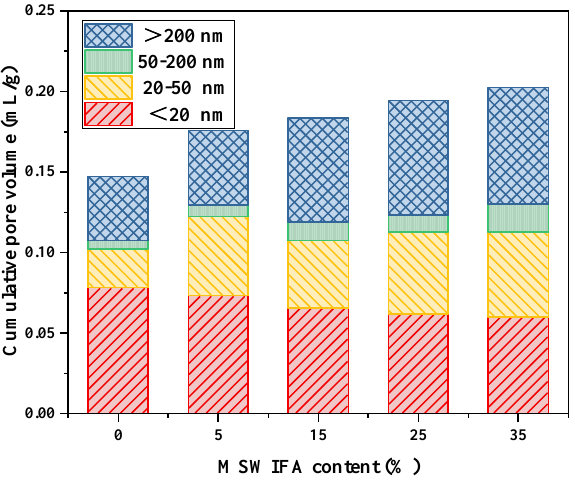
Figure 5. The pore volume distribution of geopolymer mortars.